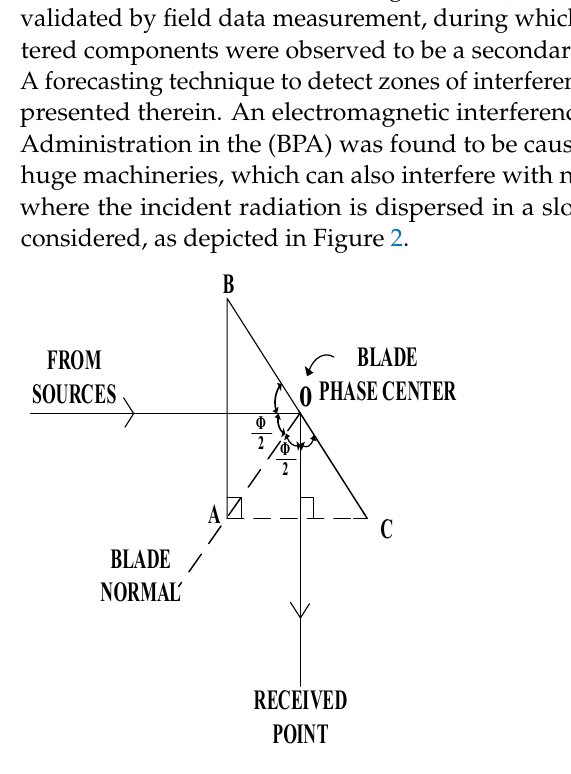
Figure 2. Electromagnetic scattering by wind turbine blade [32].